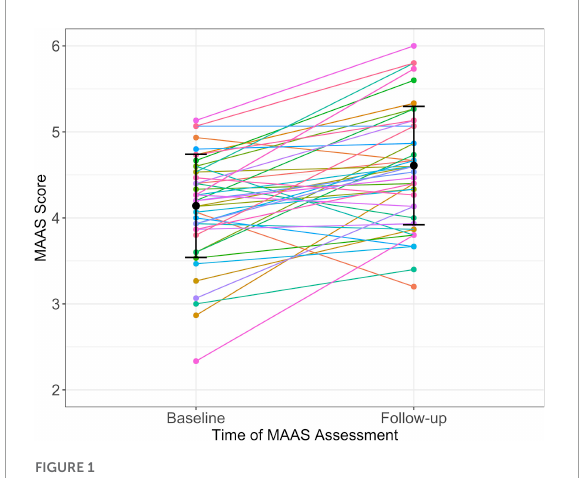
FIGURE3 Pre-drug right amygdala [ 11 C]-Cimbi-36 BP ND association with Mindful Attention and Awareness Scale (MAAS) score. Black line and gray shading: Estimated regression line and 95% confidence interval. Colored circles: Individual participants. No participants had a MAAS score < 2 or > 5. Maximum possible MAAS score =